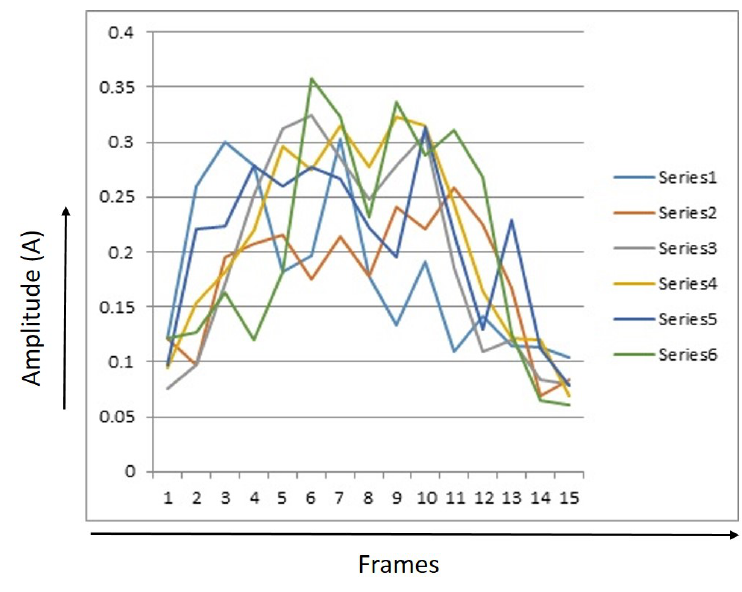
Figure 8. 15 Point RMS values of 6 event signals of elephants.